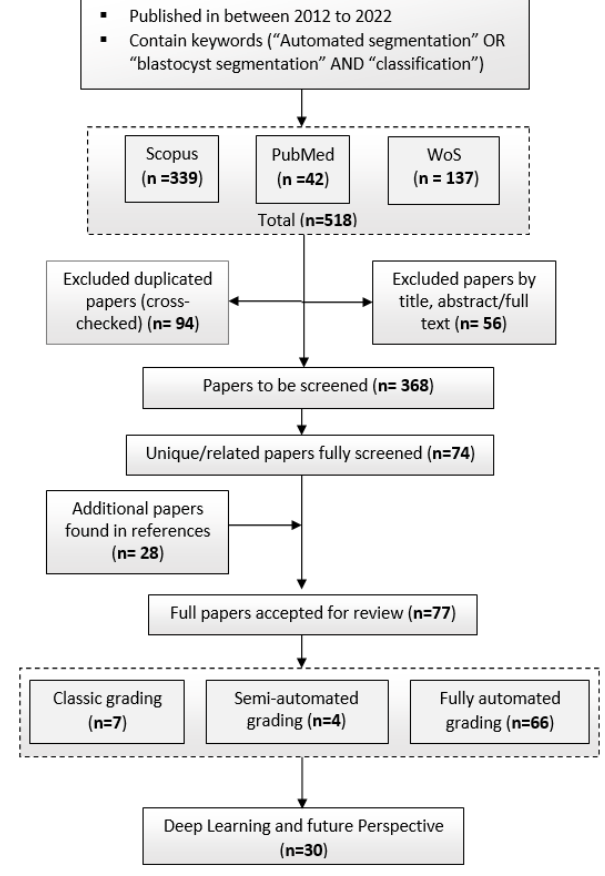
Figure 1. Literature search of study selection.